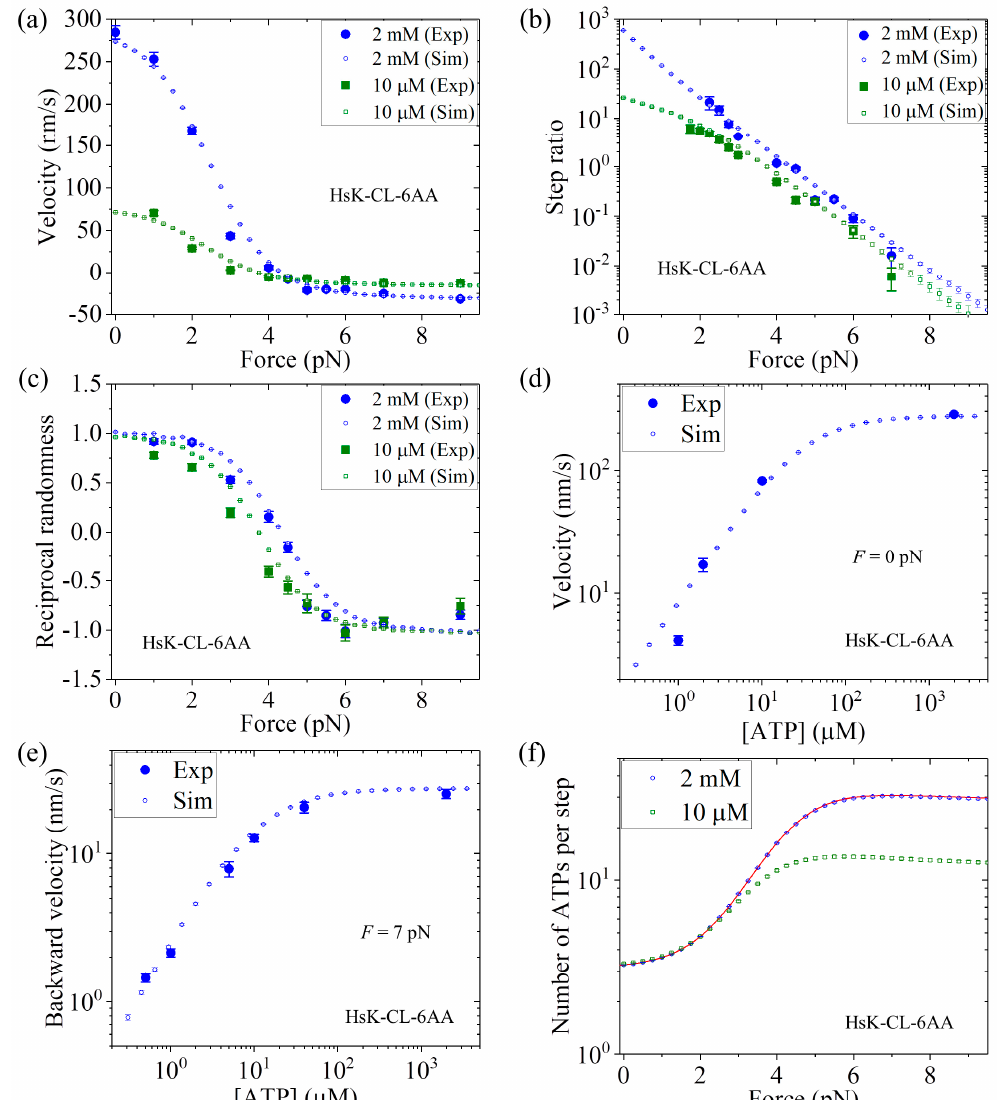
Figure 7. Dynamics of HsK-CL-6AA at different ATP concentrations. Unfilled symbols are MC simulated data, with error bars representing SEM ( n = 1000), line is the analytical solution at saturating ATP, and filled symbols are experimental data taken from Clancy et al. [26]. Adapted by permission from Springer Nature: Clancy, B.E.; Behnke-Parks, W.M.; Andreasson, J.O.L.; Rosenfeld, S.S.; Block, S.M. A universal pathway for kinesin stepping. Nat. Struct. Mol. Biol. 2011, 18, 1020–1027. Licence number: 4680780256064. ( a ) Velocity versus external force. ( b ) Stepping ratio versus external force. ( c ) Reciprocal randomness versus external force. ( d ) Velocity versus ATP concentration under no external force. ( e ) Backstepping velocity versus ATP concentration under backward force of 7 pN. ( f ) Number of ATP molecules consumed per step versus external force.